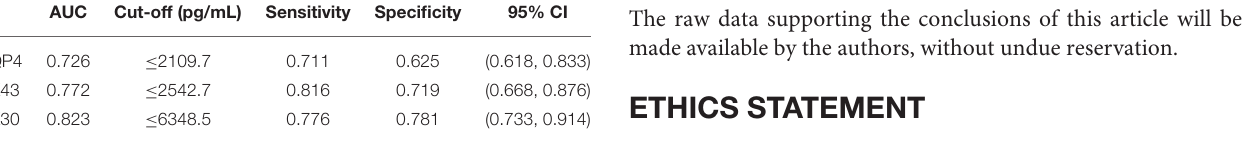
TABLE 6 | Characteristics of potential blood biomarkers for CID in ROC analysis. AUC Cut-off (pg/mL) Sensitivity